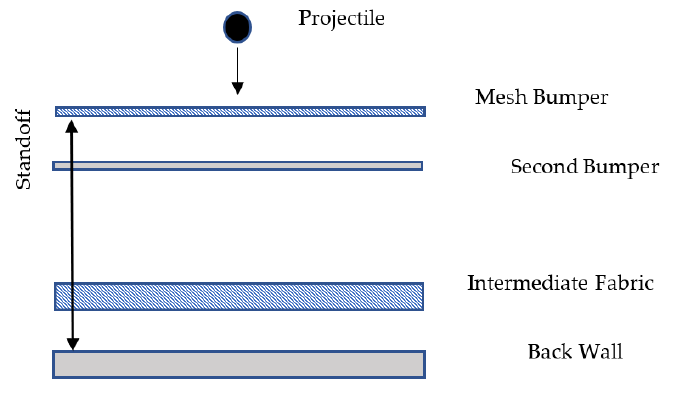
Figure 20. Mesh Double Bumper shield.